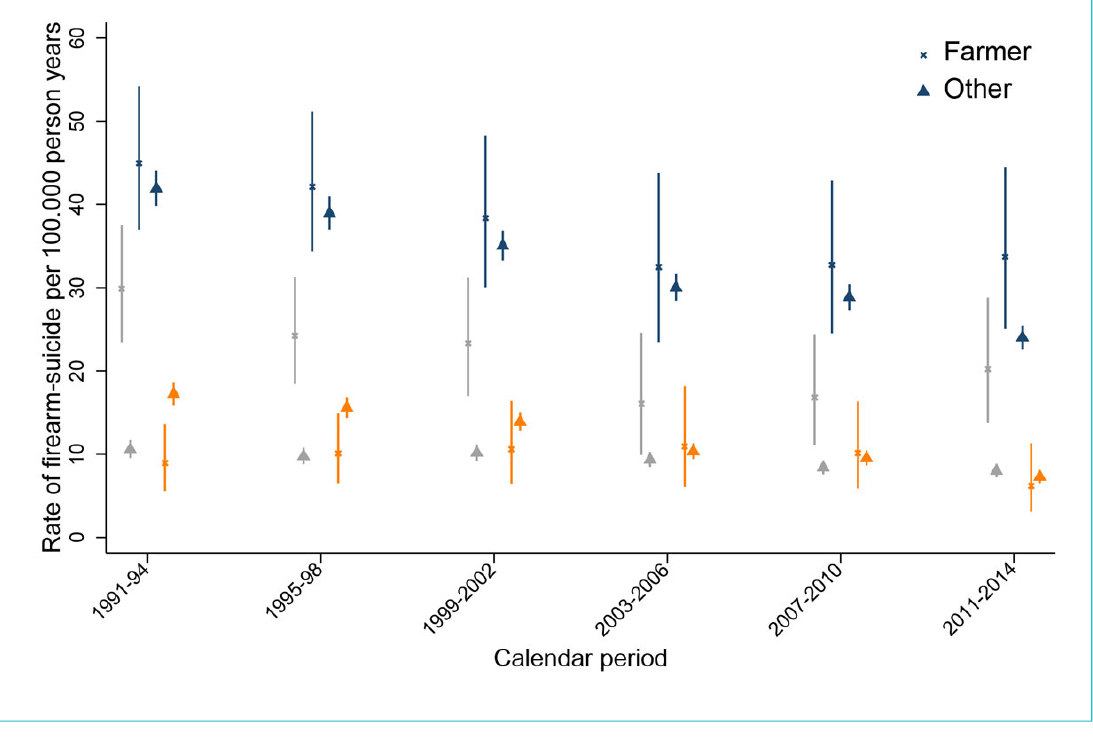
Figure 2: Age-standardised * suicide rates of the study population: farmers and men with other professions by calendar period (95% confi- dence intervals), all methods of suicide (navy), suicides by hanging (grey) and suicides by firearms (orange).* Compared with with the Euro- pean Standard Population (2013)